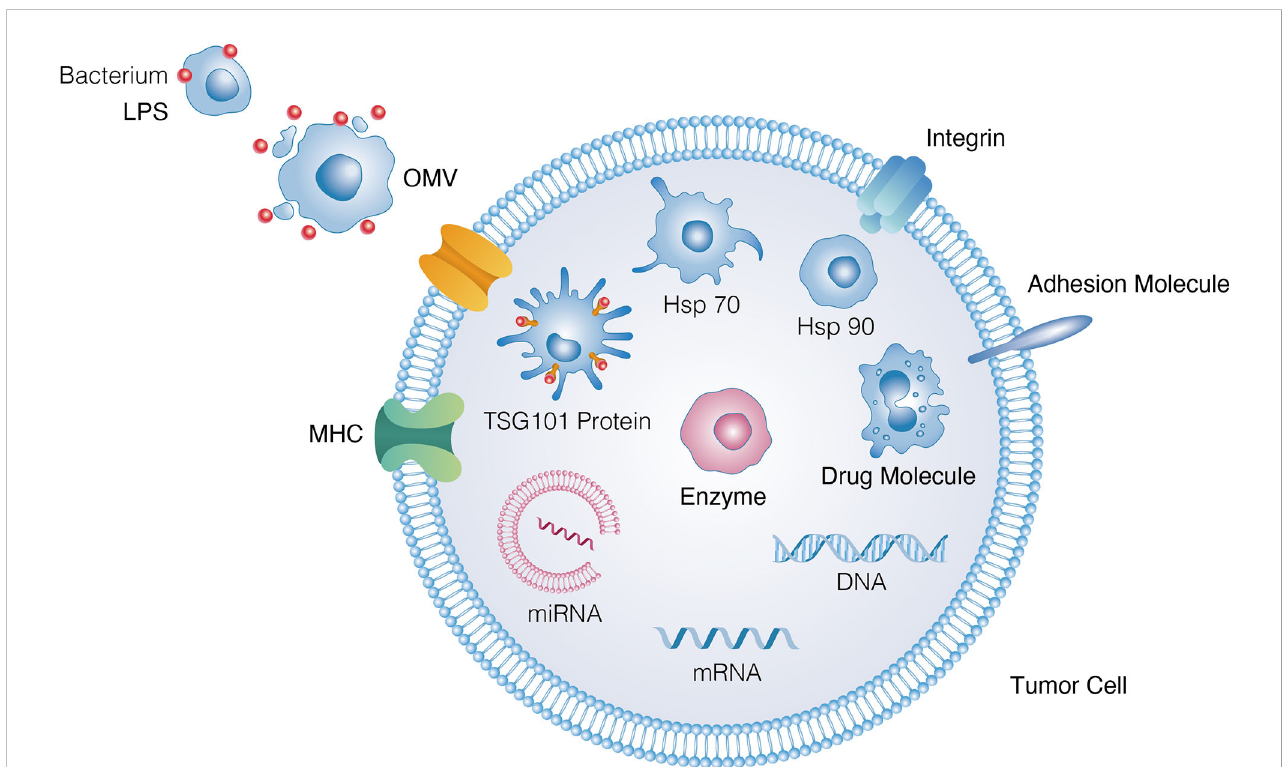
FIGURE 6 Biological effects that OMVs conferred to tumor cells and key molecules mediating such